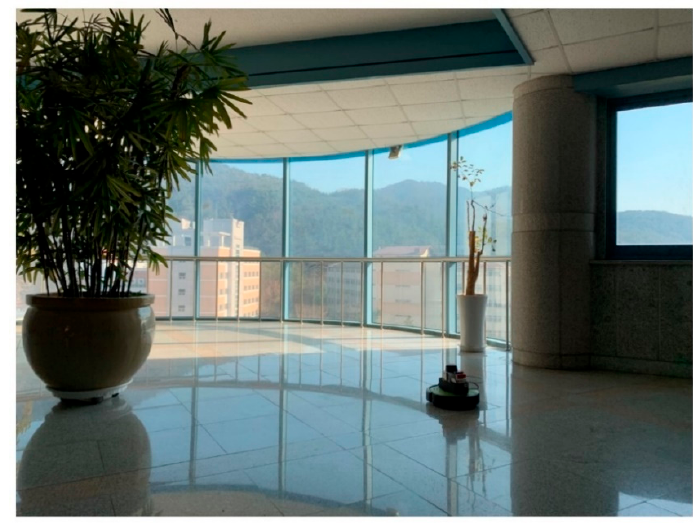
Figure 9. Indoor space (lobby) wherein experiment was performed. This was for the manual operation experiment.